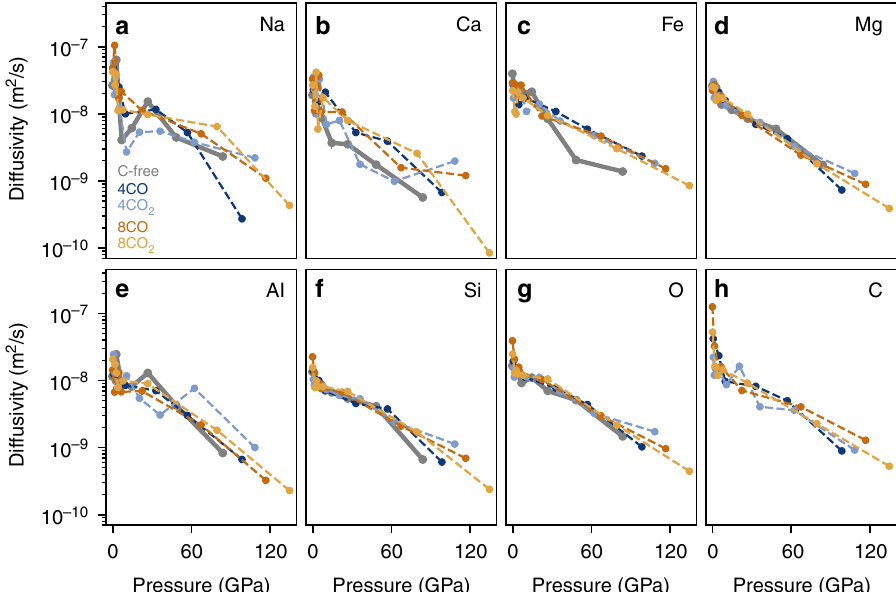
Fig. 4 Elemental diffusivities at 4000 K. Diffusion coef fi cients for ( a ) sodium, ( b ) calcium, ( c ) iron, ( d ) magnesium, ( e ) aluminum, ( f ) silicon, ( g ) oxygen, and ( h ) carbon in pure pyrolite (bold gray), pyrolite + 4CO (3.35 wt% CO) (dark blue), pyrolite + 4CO 2 (5.16 wt% CO 2 ) (light blue), pyrolite + 8CO (6.48 wt% CO) (dark orange), and pyrolite + 8CO 2 (9.82 wt% CO 2 ) (yellow). The axes are identical for each panel. The scatter in the diffusion rates for Na, Ca, and Al is due to the low abundance of those atoms in our melt (our melt contains one Na, two Ca, and three Al